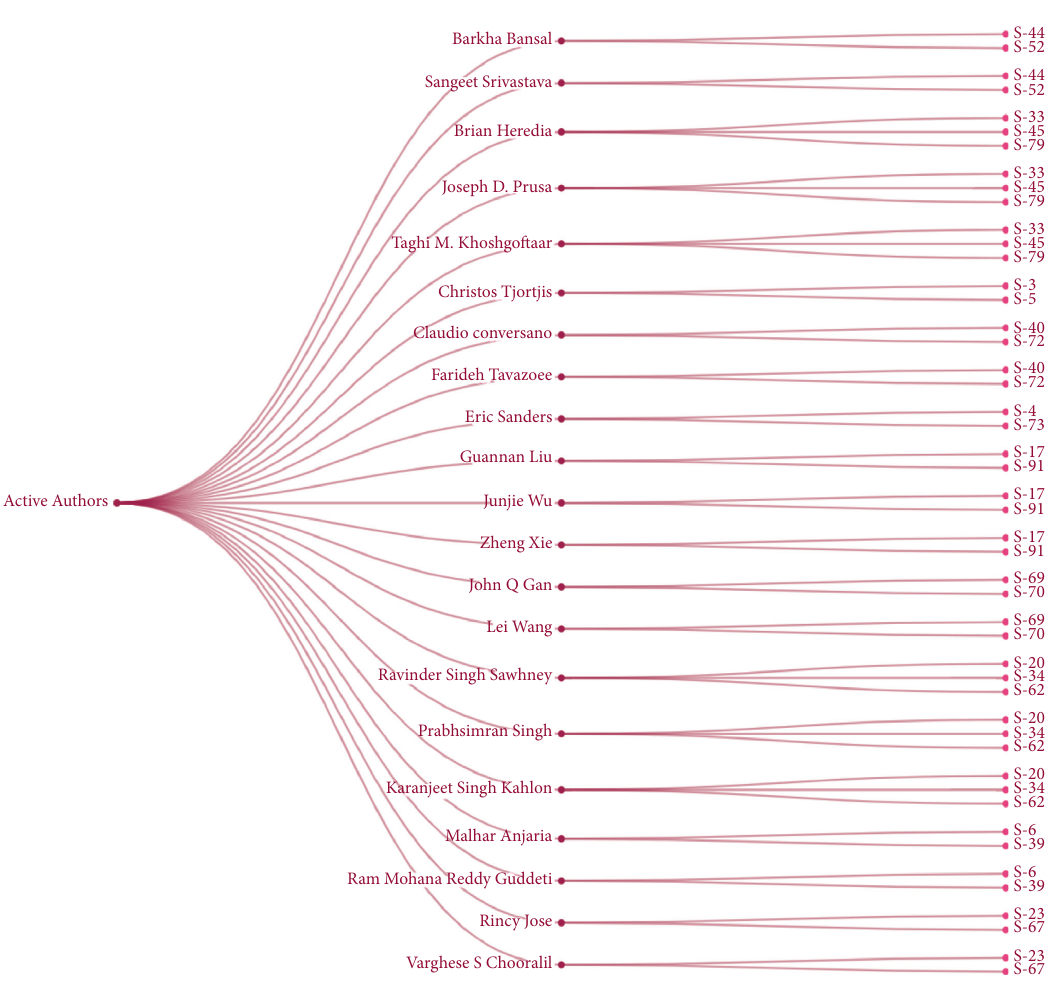
Figure 17: Most active authors in the selected studies.